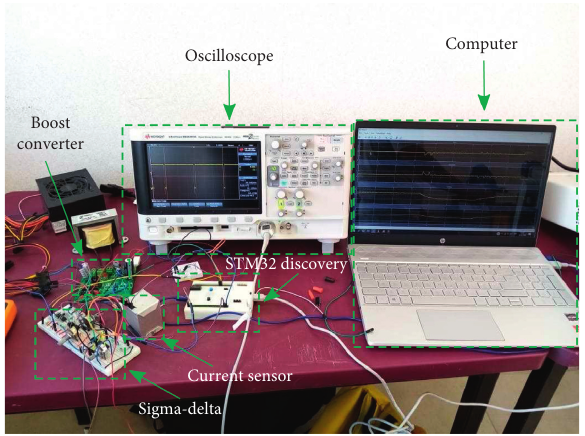
Figure 15: Photograph of the prototype.